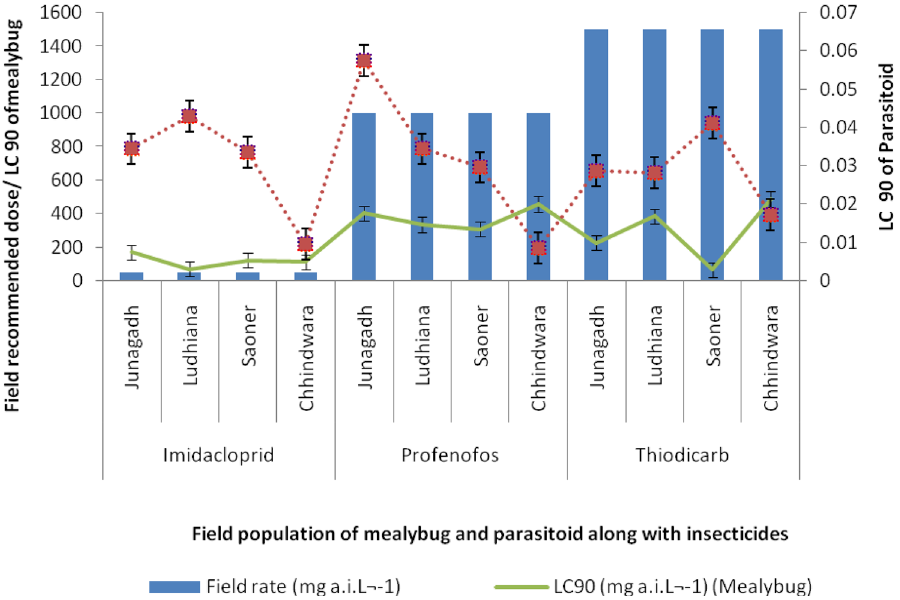
Figure 2. Comparison of contact LC90 values of insecticides to mealybug and parasitoid with their field recommended concentrations. The expected mortality of field populations of P. solenopsis as achieved by label rates is represented graphically. The toxic impact of these insecticides on A. arizonensis field populations could be deduced from this graph. Susceptibility of the four field populations of P. solenopsis as given by the estimates of LC 50 and 95% confidence limits for the tested insecticides was compared with the maximum recommended field dose of these insecticides by Central Insecticides Board and Registration Committee (CIBRC), Government of India. As per CIBRC, the recommended doses for the tested insecticides against sucking pests were: imidacloprid 0.00625 mg L −1 ; profenofos: 0.125 mg L −1 ; thiodicarb: 0.185 mg L −1